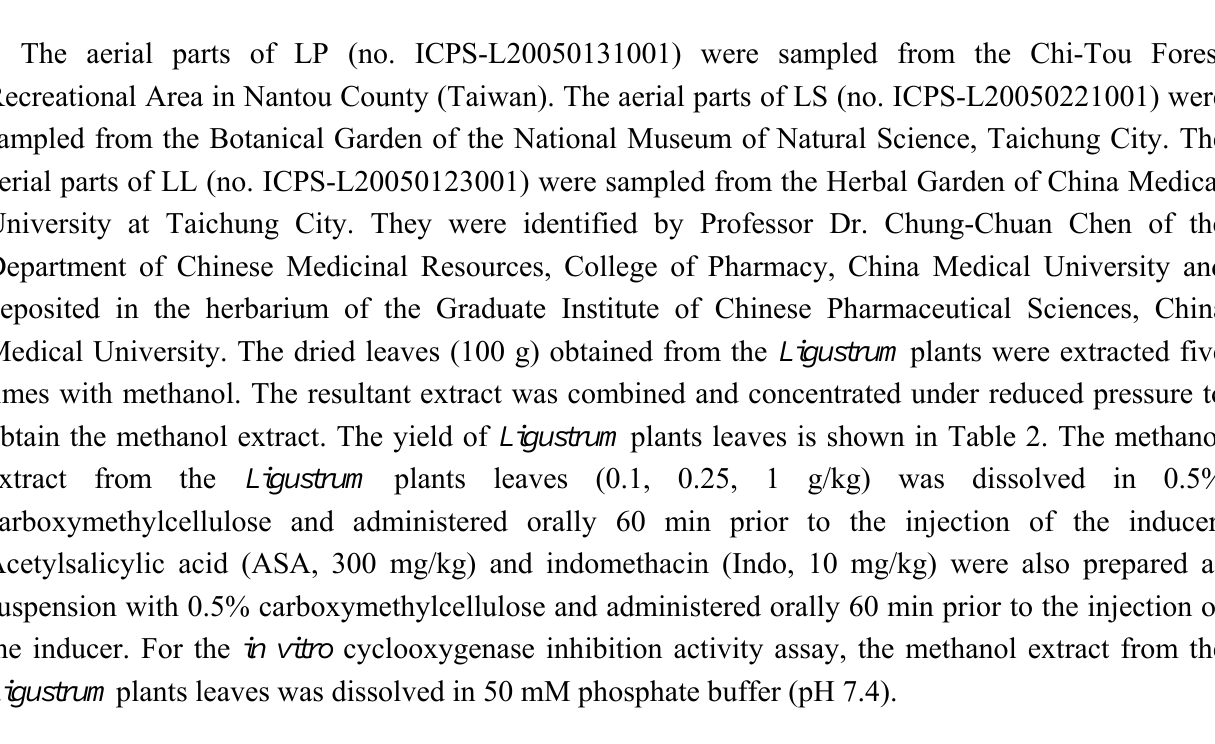
Table 2. The yield and triterpenoid contents of Ligustrum plants leaves extracted with methanol. Amyrin Betulin Betulinic acid Lupeol Oleanolic acid Ursolic acid Yield Plants (%) ( μ g/g) ( μ g/g) ( μ g/g) ( μ g/g) ( μ g/g) ( μ g/g) L. pricei 16.34 3782.81 ± - 1877.89 ± 3765.78 ± 380.21 ± 38.83 * 5.82 *** 61.69 * 5.90 ** L. sinense 28.74 2031.93 ± - 313.43 ± 7.53 1983.26 ± 24.31 36.71 L. lucidum 41.77 603.86 ± 623.63 ± 472.26 ± 1.72 ** 5.99 *** 3.32 6.84 *** Data were expressed as mean ± SEM for three repeats. * p < 0.05, ** p < 0.01, *** p <